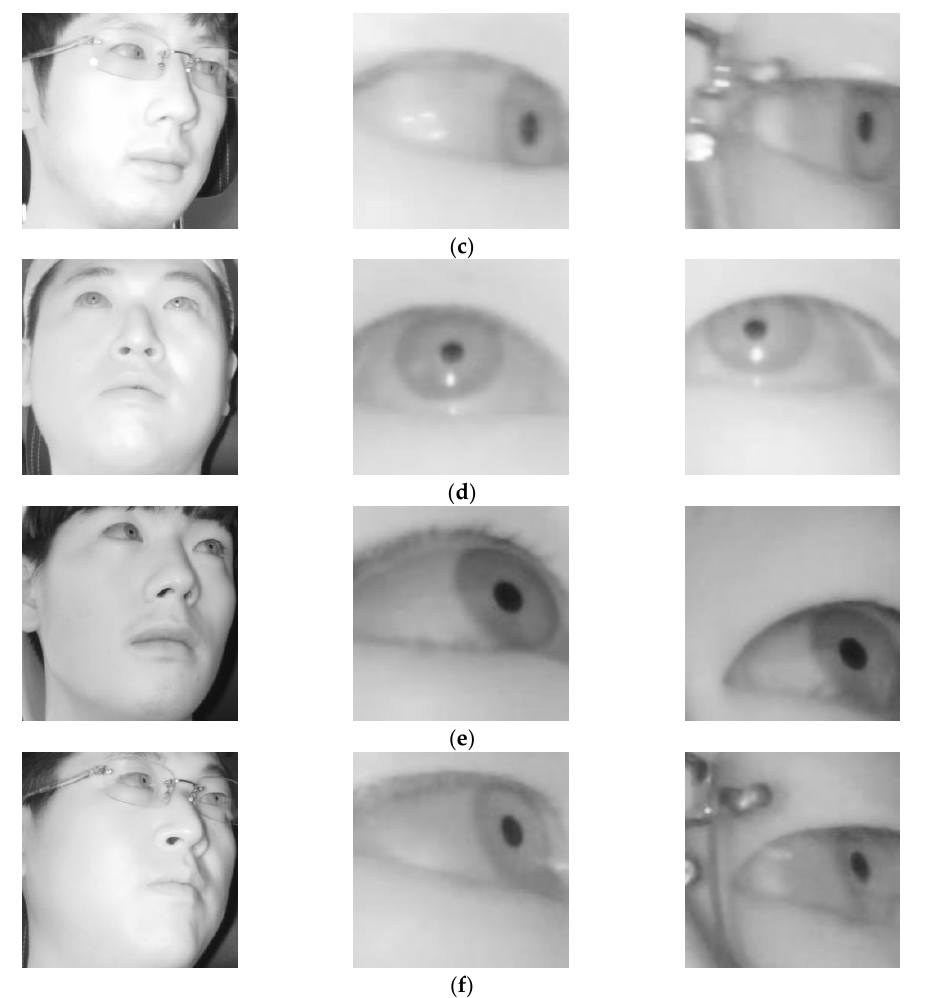
Figure 10. Example images of face ( left ), left eye ( middle ), and right eye ( right ) while looking at different regions of Figure 3. Cases of looking at ( a ) region 1; ( b ) region 2; ( c ) region 5; ( d ) region 6; ( e ) region 7; and ( f ) region 8.